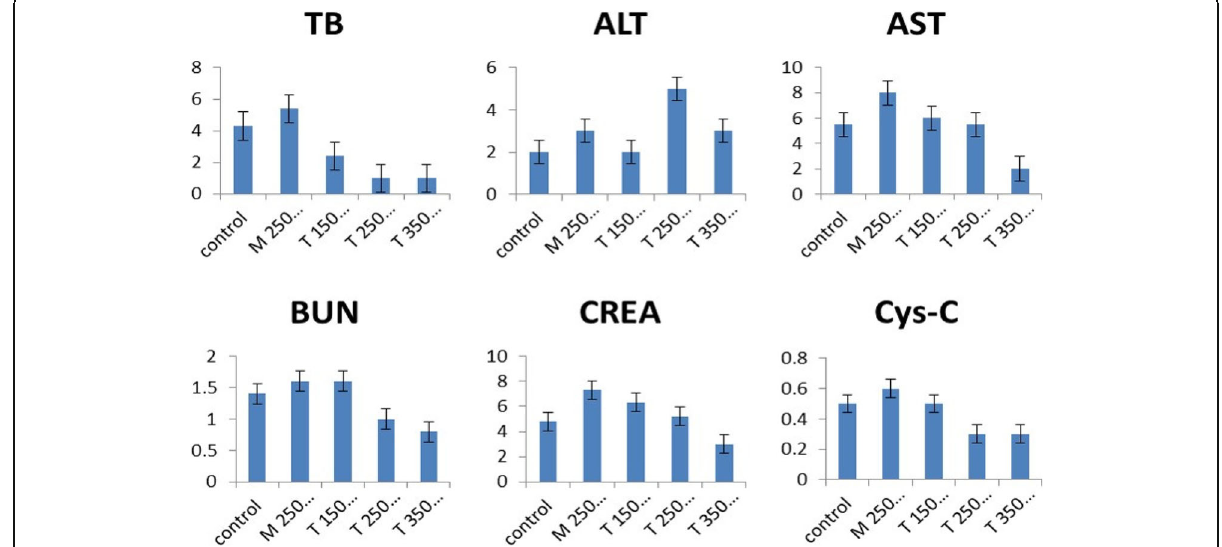
Fig. 8 Biochemical indexes content in serum after different dosages (in μ g) of PEG-CoFe 2 O 4 exposure to mice with error bars shown in the